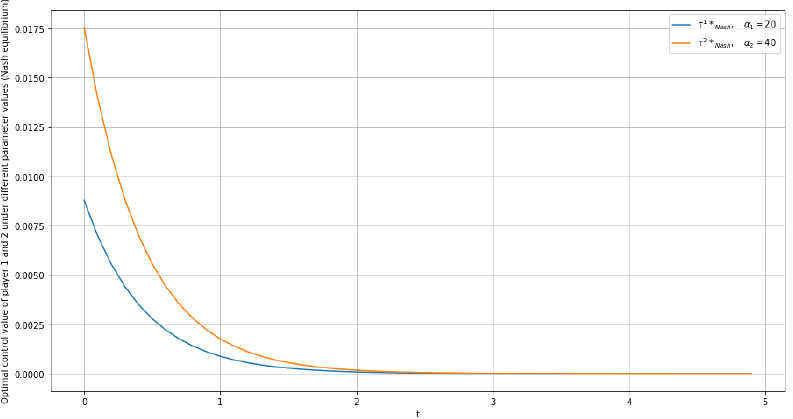
Figure 3. The optimal controls of two players under Nash equilibrium and different α